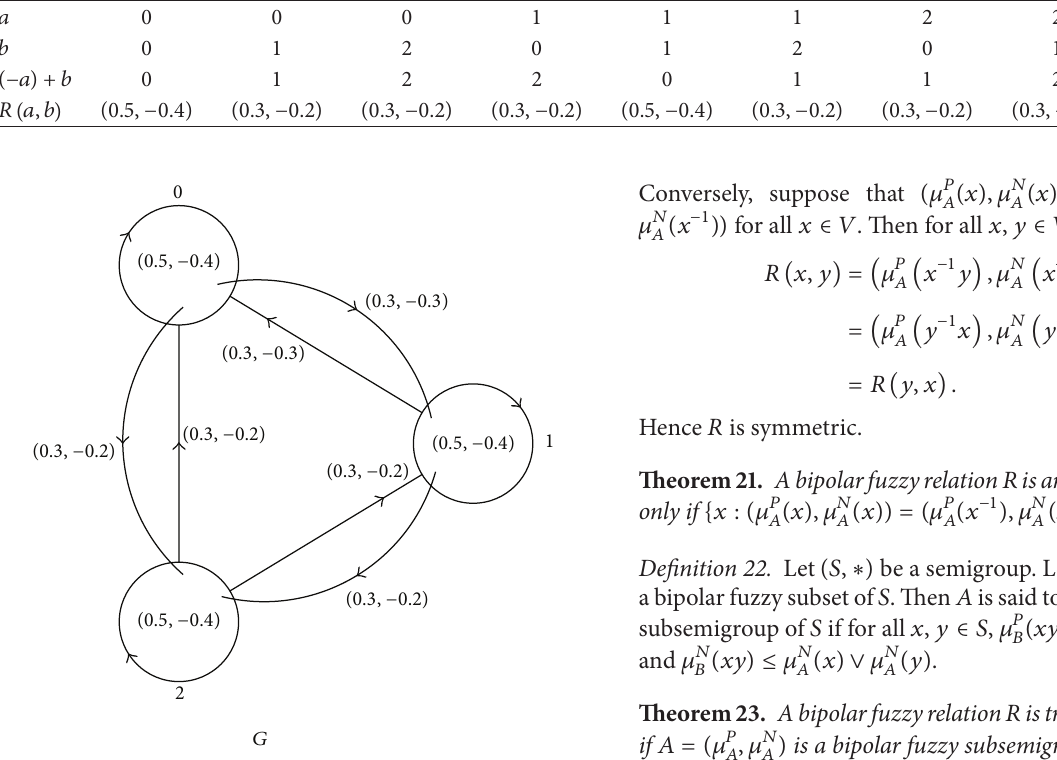
Figure 1: Cayley bipolar fuzzy